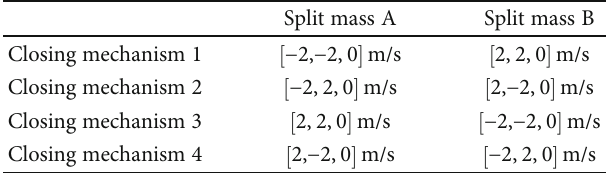
Table 3: Separation velocity of the split masses.